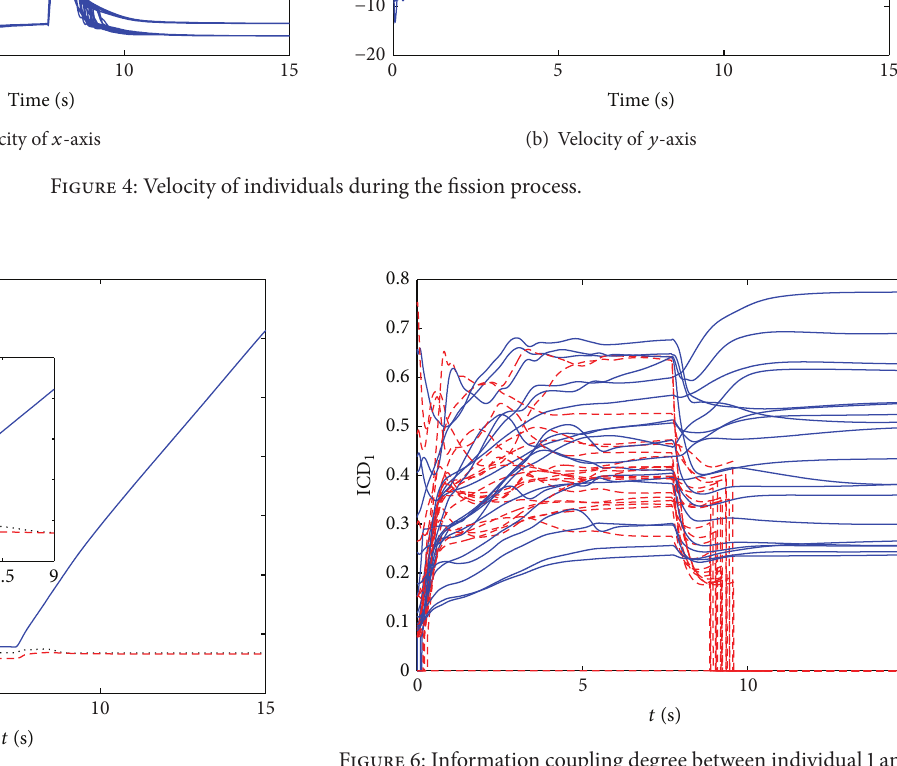
Figure 6: Information coupling degree between individual 1 and its